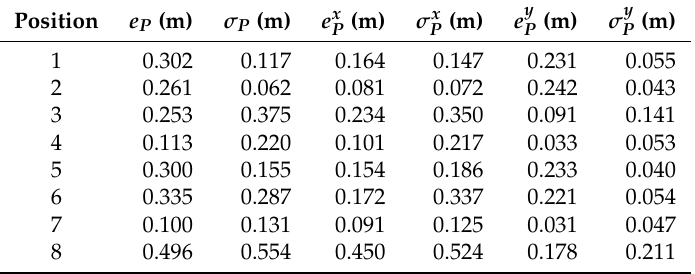
Table 4. Measured accuracy of the PSO algorithm in Scenario 2.